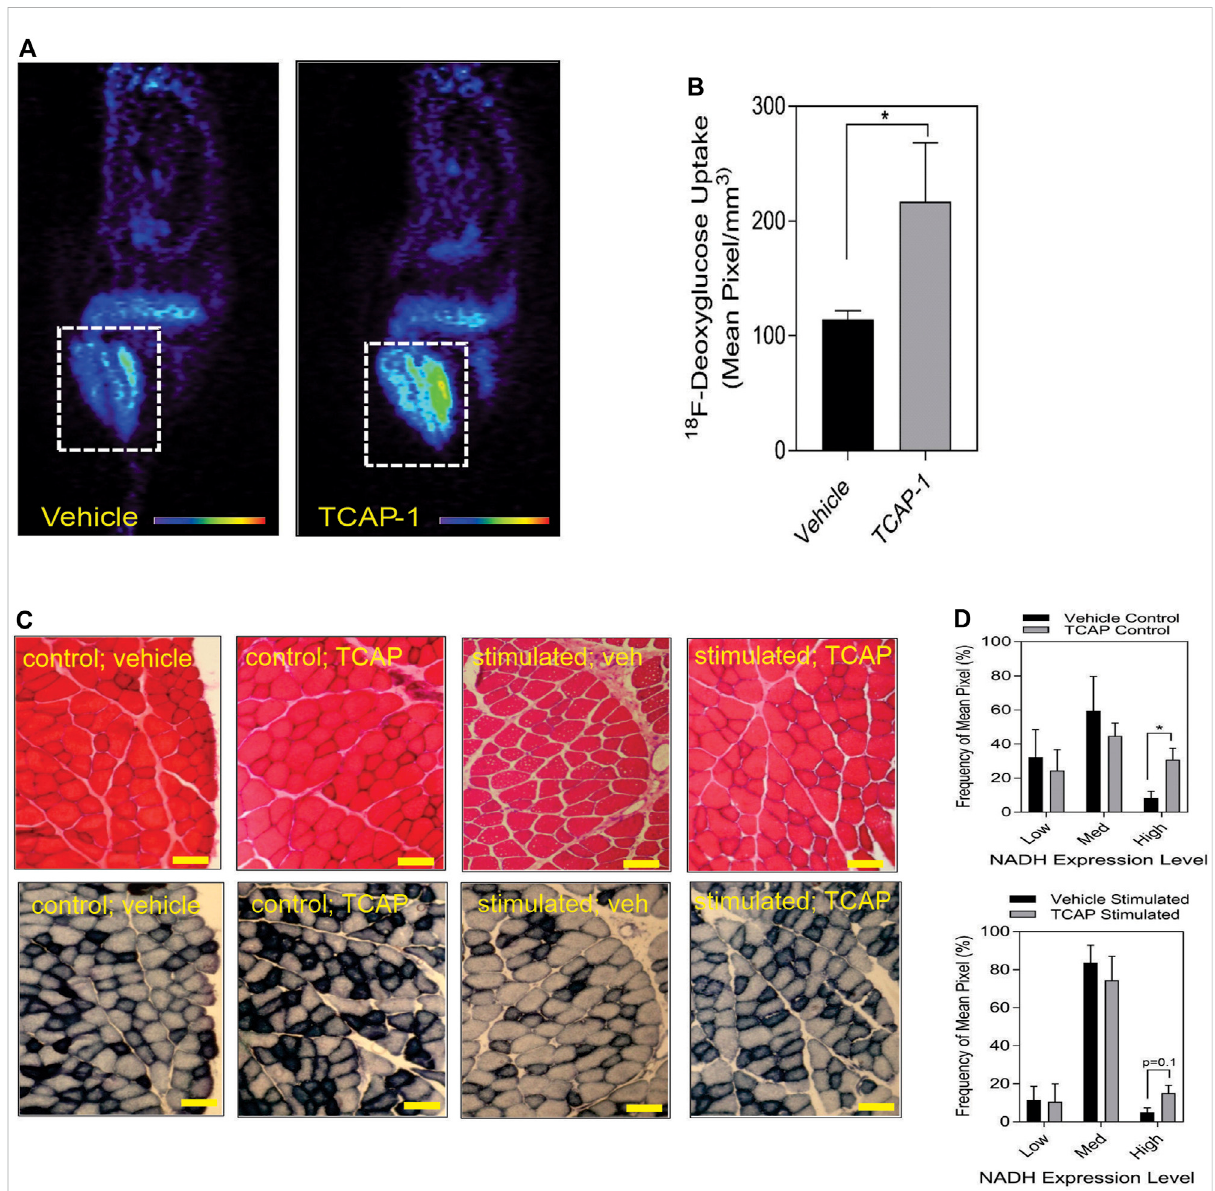
FIGURE 4 Glucose uptake and metabolism in rat hind-limb and TA muscle. (A) functional Positronic Emission Tomography of rat hind limb showing increase of 18 F-deoxyglucose ( 18 F-DG) uptake after 3 days from TCAP-1 administration. (B) . Quanti fi cation of the 18 F-DG uptake in hindlimb after 3 days. ( n = 5;student ’ s t -test; p < 0.05). (C). Stimulation of NADH in TA muscle after administration of TCAP-1. Above panel, (hematoxylin and eosin stain), bottom panel, NADH activity (shown as black regions). Scale bar indicates 100 µM. (D) . Quanti fi cation of the NADH-labelled cells